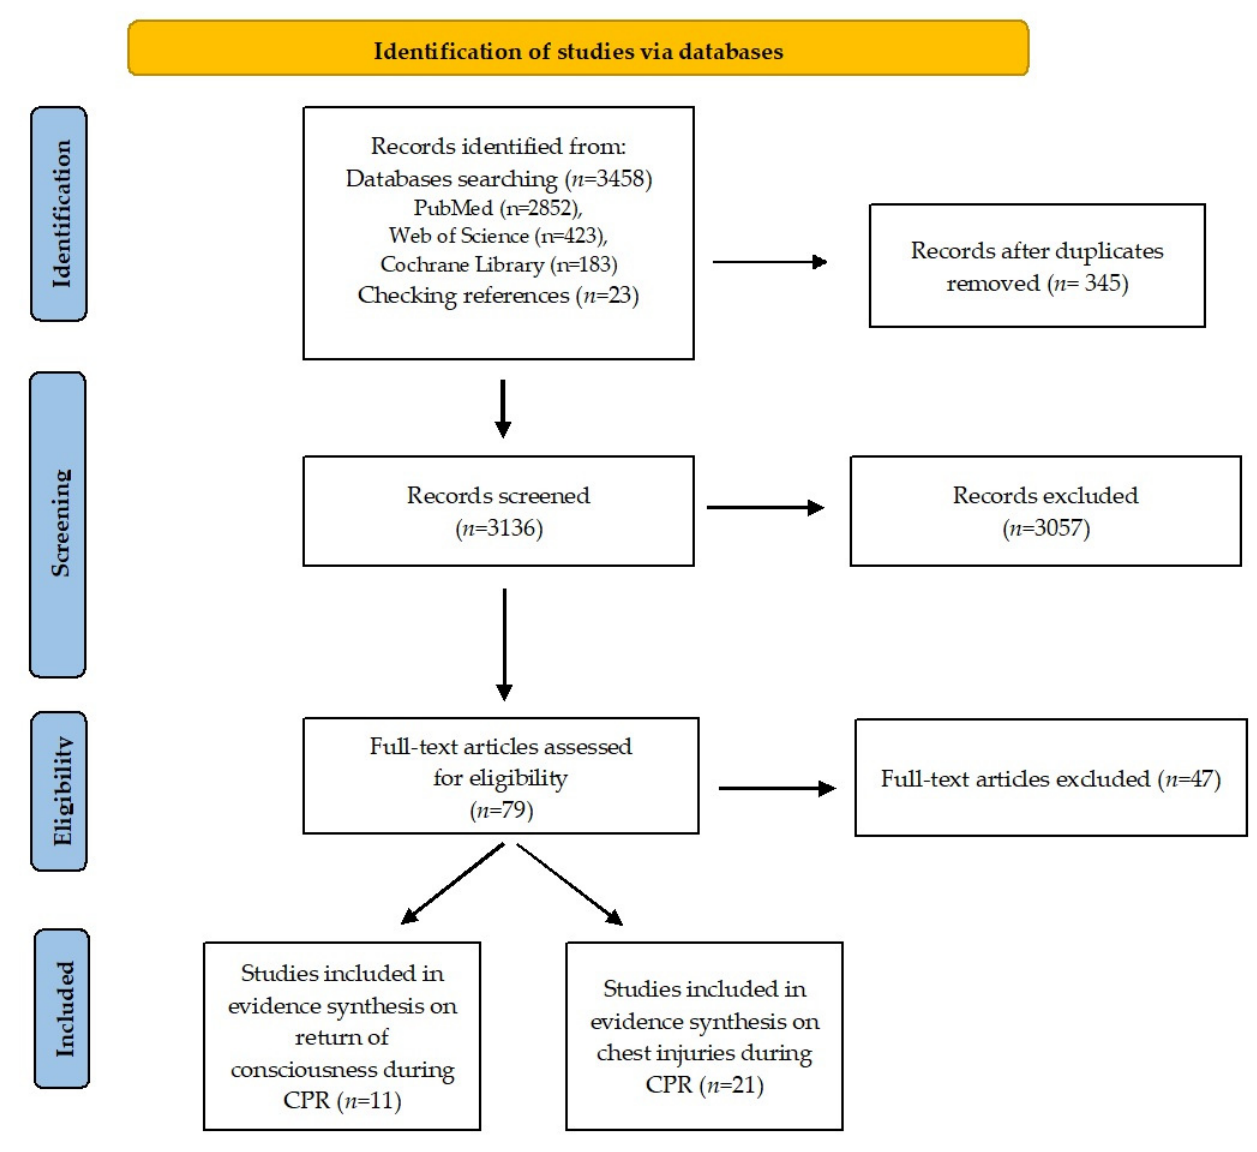
Figure 1. PRISMA flow diagram. Reprinted/adapted with permission from Ref. [14]. 2020, Mat- thew J Page